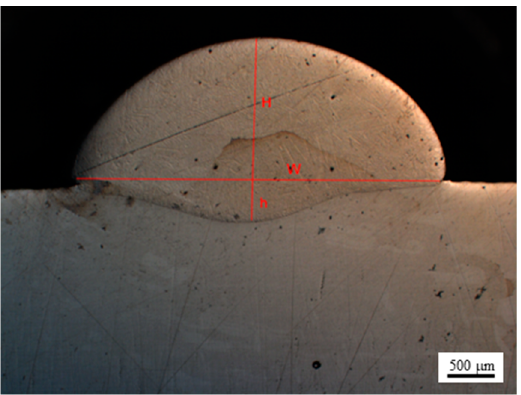
Figure 3. Feature size of single layer single pass laser cladding layer.